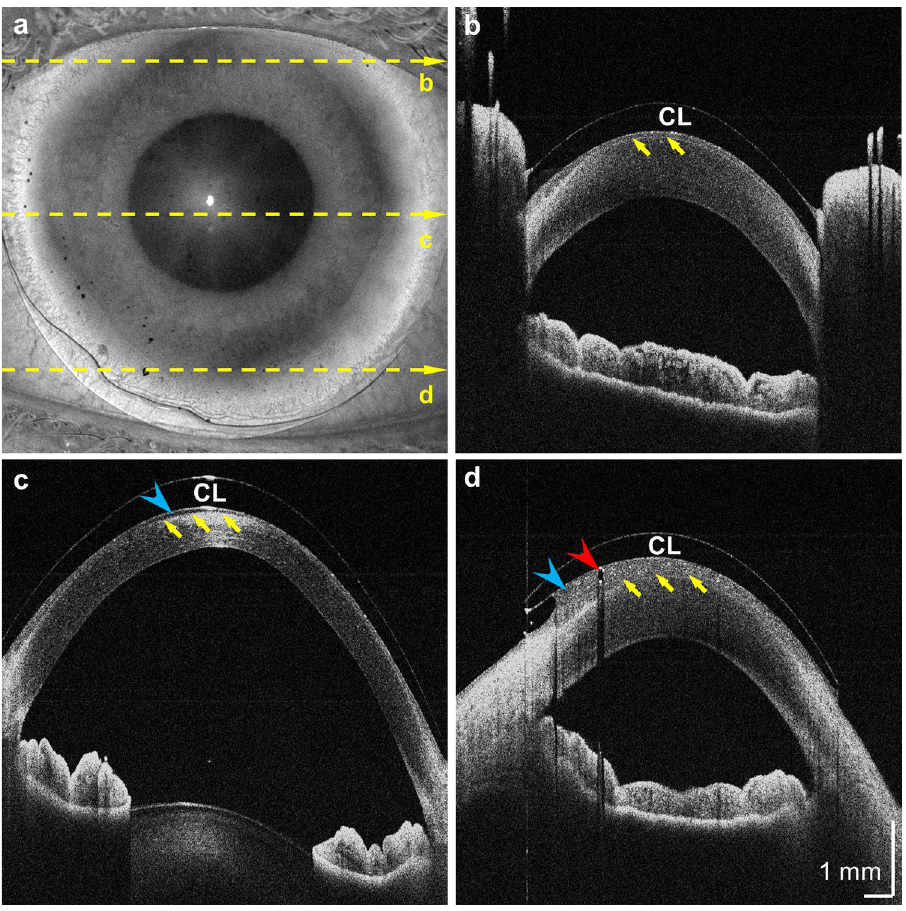
Figure 3. 15-mm OCT volume of an eye with a hard contact lens (CL). ( a ) En face projection of the OCT signal. ( b )–( d ) B-scans extracted from locations indicated in ( a ). Yellow arrows: corneal epithelium. Blue arrowhead: fluid trapped between the contact lens and the cornea. Red arrowhead: Air bubble inclusion. The sharp discontinuity in the refractive index creates a strong shadowing artifact.